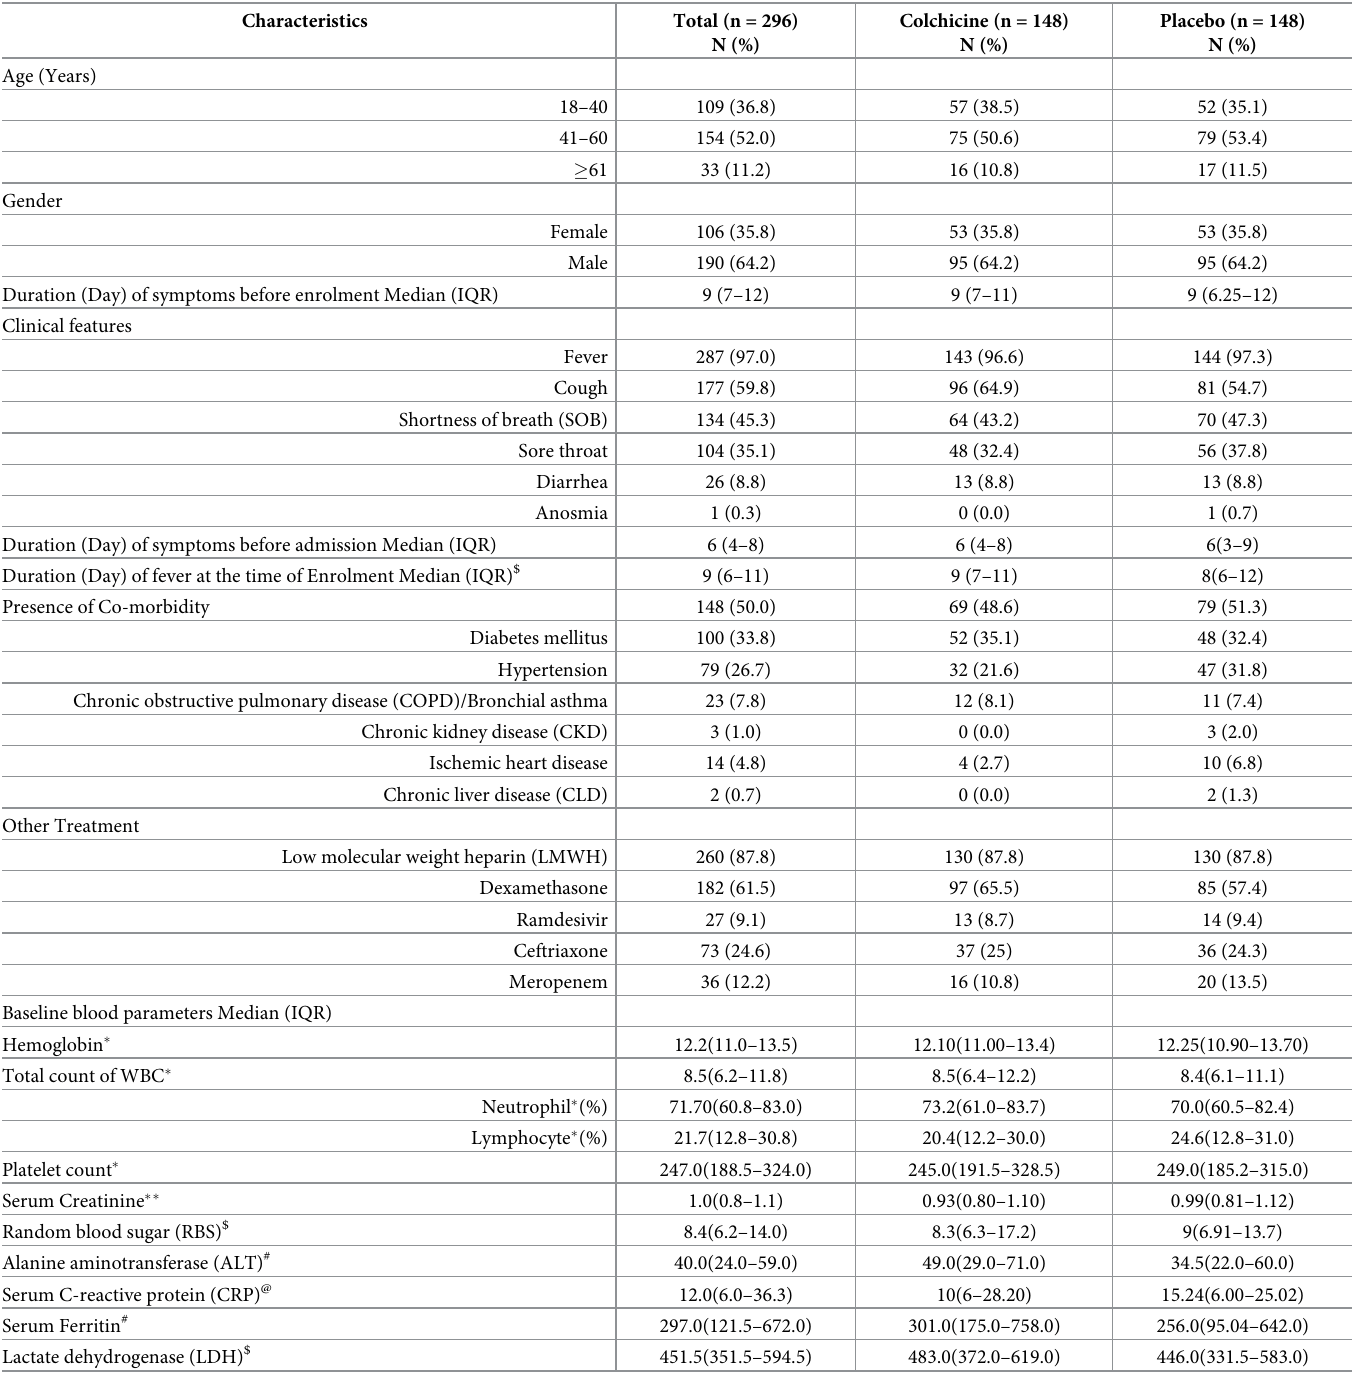
Table 1. Baseline characteristics of the study